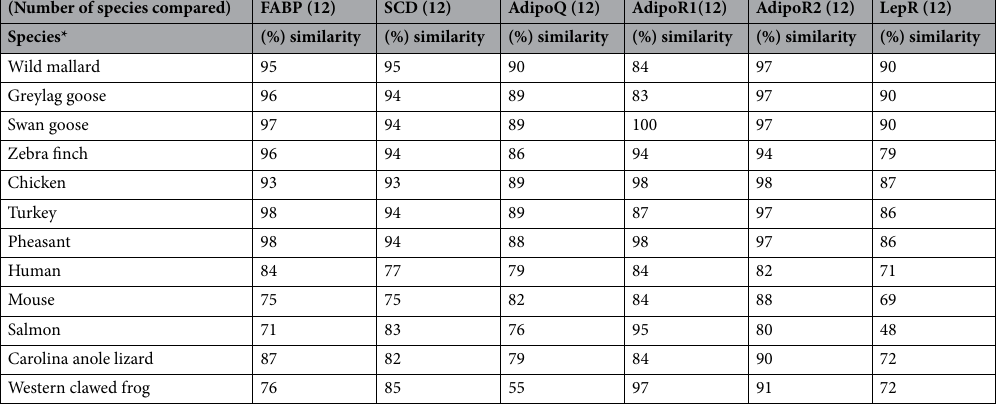
Table 5. Amino Acids sequences identities and similarities of FABP4, SCD1, AdipoQ, AdipoR1, AdipoR2 and LepR between emu ( D. novaehollandiae ) and 12 other animal species*. *Wild mallard ( A. platyrhynchos ), Greylag goose ( A. anser ), Swan goose ( A. cygnoides ), zebra finch ( T. guttata ), chicken ( G. gallus ), turkey ( M. gallopavo ), pheasant ( P. colchicus ), human ( H. sapiens ), mouse ( M. musculus ), Salmon ( S. salar ), Carolina anole lizard ( A. carolinensis ), Western Clawed Frog ( X. tropicalis